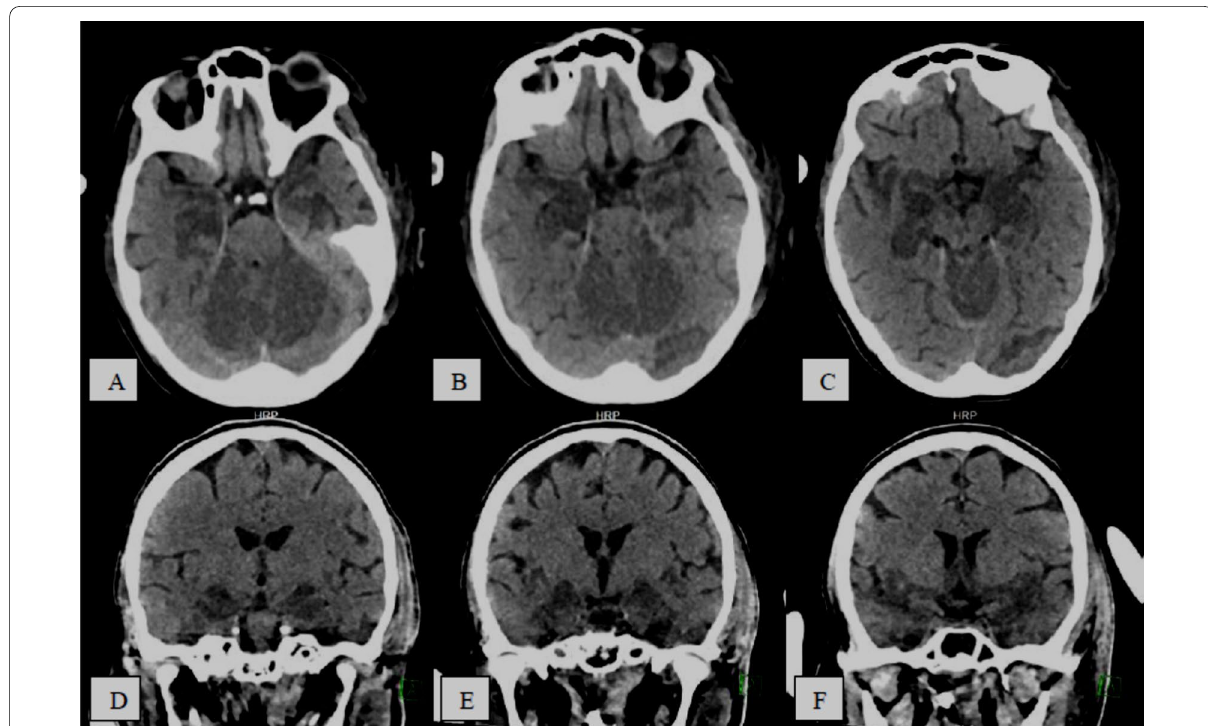
Fig. 6 22-year-old-female COVID-19 positive patient complaining of worsening pneumonia and difficult to oxygenate. Presented with impaired level of consciousness, A – C and D – F serial axial and coronal CT images, respectively, show bilateral cerebellar and medial temporal lobe hypo-attenuation with relative loss of gray white matter differentiation, suggestive of hypoxic ischemic encephalopathy (global hypoxic-ischemic injury) with COVID-19 related leukoencephalopathy